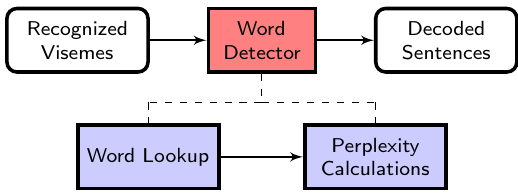
Figure 3. Processes of word